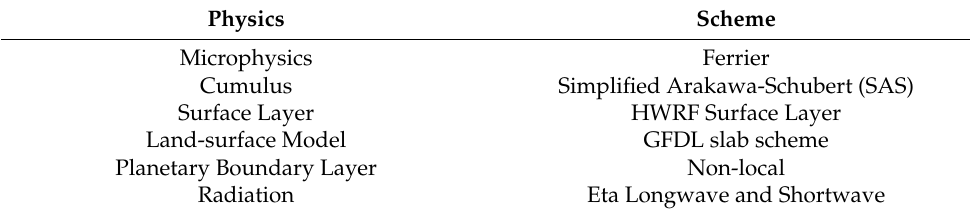
Table 3. Table of model physics used for Edouard